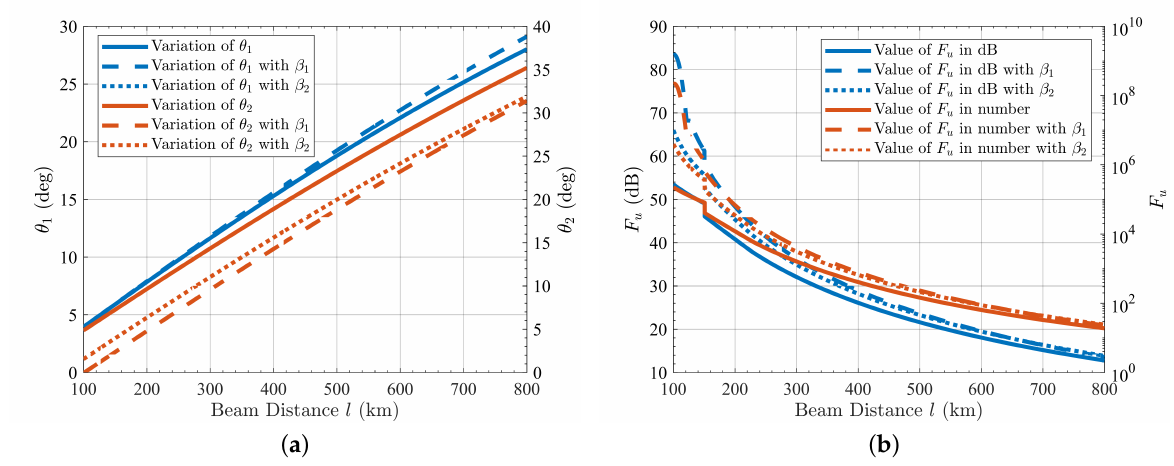
Figure 6. Relationship between off-axis angles θ 1 , θ 2 , and F u and beam distance l , with different tilting angles β 1 and β 2 . ( a ) Relationship between variations of θ 1 , θ 2 , and beam distance l with different value of tilting angle β 1 and β 2 ; ( b ) Relationship between F u in dB, F u in number, and beam distance l with different value of tilting angle β 1 and β 2